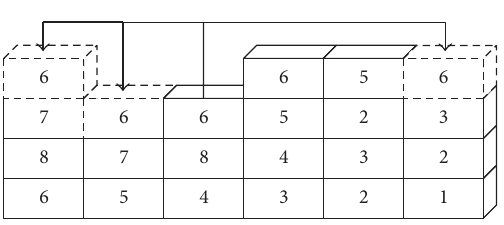
Figure 5: Optimization position of relocation